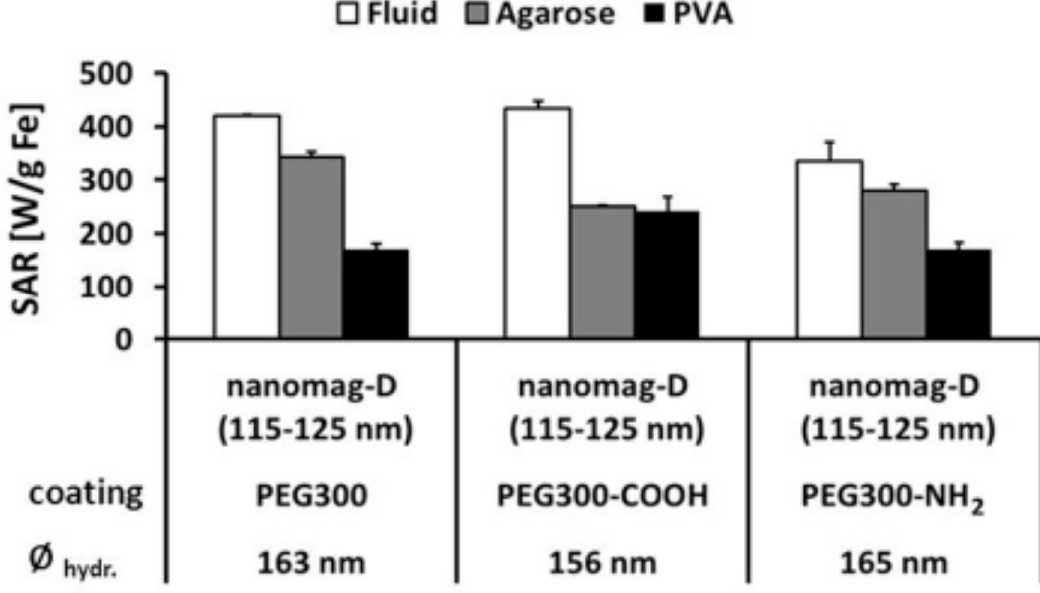
Figure 31. SAR diminishing after immobilization in agarose and PVA (reprinted from [280] under Open Access license).